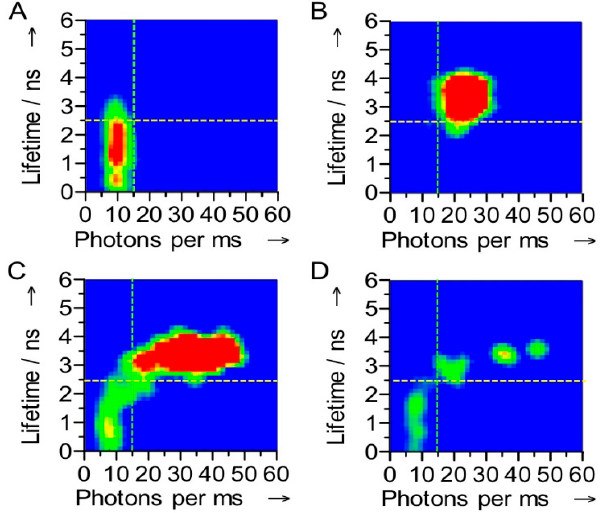
Figure 4. Correlograms of the fluorescence intensity and the fluorescence lifetime of a single Az-NiR-647N molecule. The measurements were performed under oxidizing ( A ), reducing ( B ) and turnover conditions ( C , D ). The stippled lines show how the molecules were divided into ox and red in the FLIM experiments (see text). The data were obtained with 4 ms binning times. The color is indicative of the frequency of occurrence in the histograms, a change from green to red corresponding with an increase in